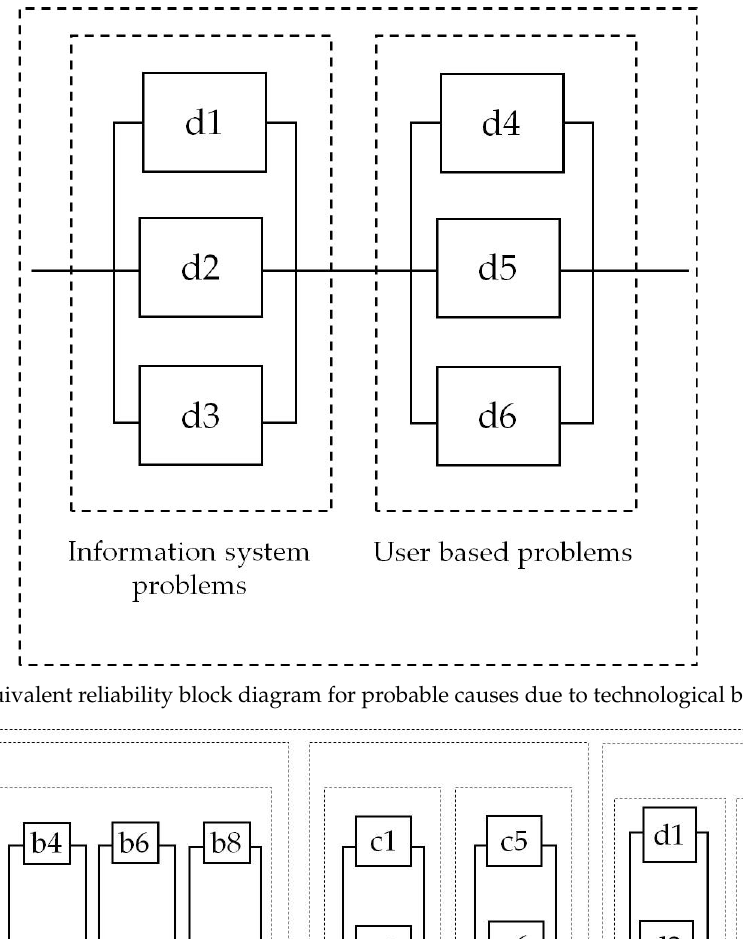
Figure 8. Equivalent reliability block diagram for probable causes due to technological barriers (T).